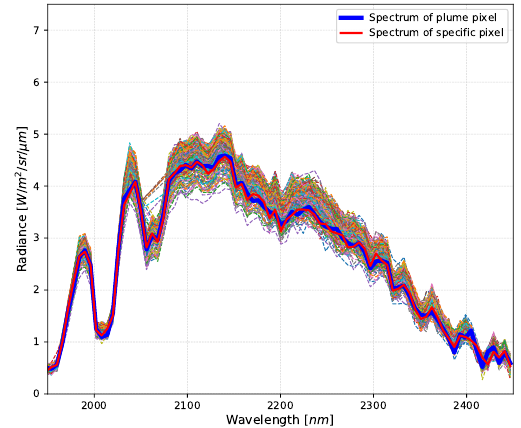
Figure 4. Spectral radiance of HySpex image pixels. The blue curve corresponds to one random pixel of the plume while the red curve is the specific pixel chosen by minimisation of the RMSE. The other thin curves represent all pixels of the same blue pixel class and in the surrounding of the plume